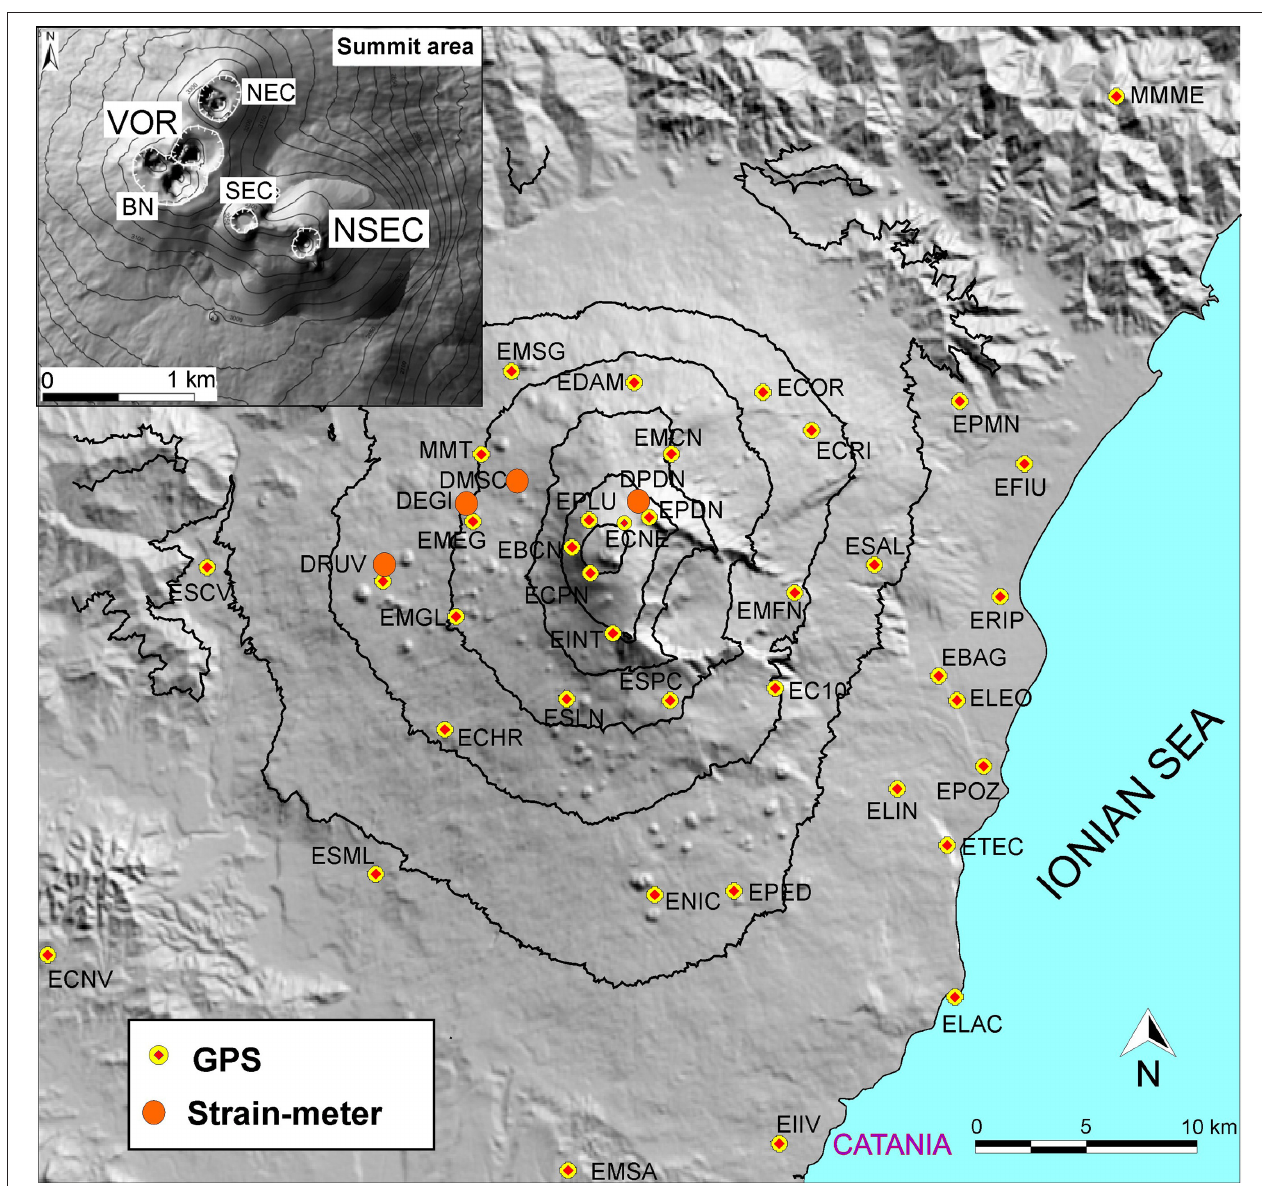
FIGURE 1 | Etna map and multidisciplinary stations used in this study (GPS and borehole dilatometer networks). In the upper-left inset, the detail of the summit craters is shown. They are: Voragine (VOR), NE crater (NEC), Bocca Nuova (BN), SE crater (SEC), New SE crater